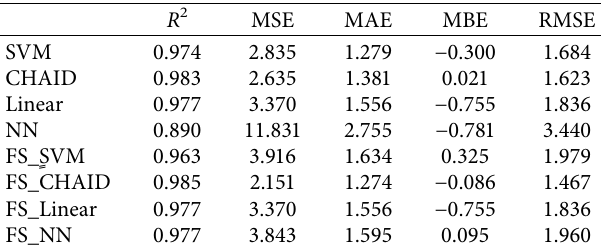
Table 7: Results of the testing data set with and without feature selection model.